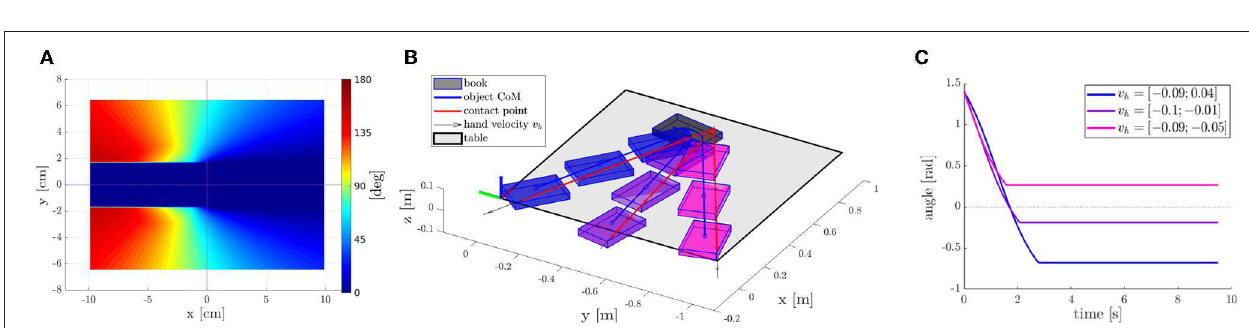
joining point O (origin of the object frame) to the point P (contact point), the following relation for the velocities